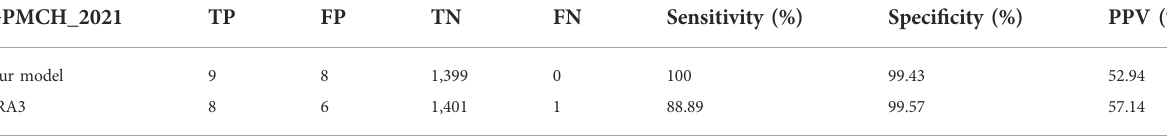
TABLE 4 Comparison with LRA3 in the GPMCH_2021 dataset.